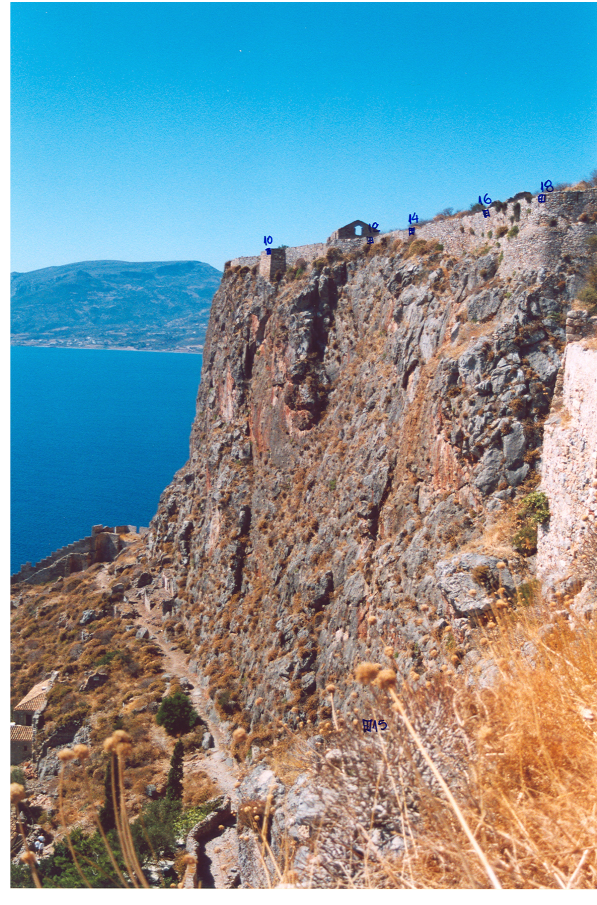
Fig. 2. Photo of a section of the high rock slope and the Monemva- sia historical site (Section C in Fig.